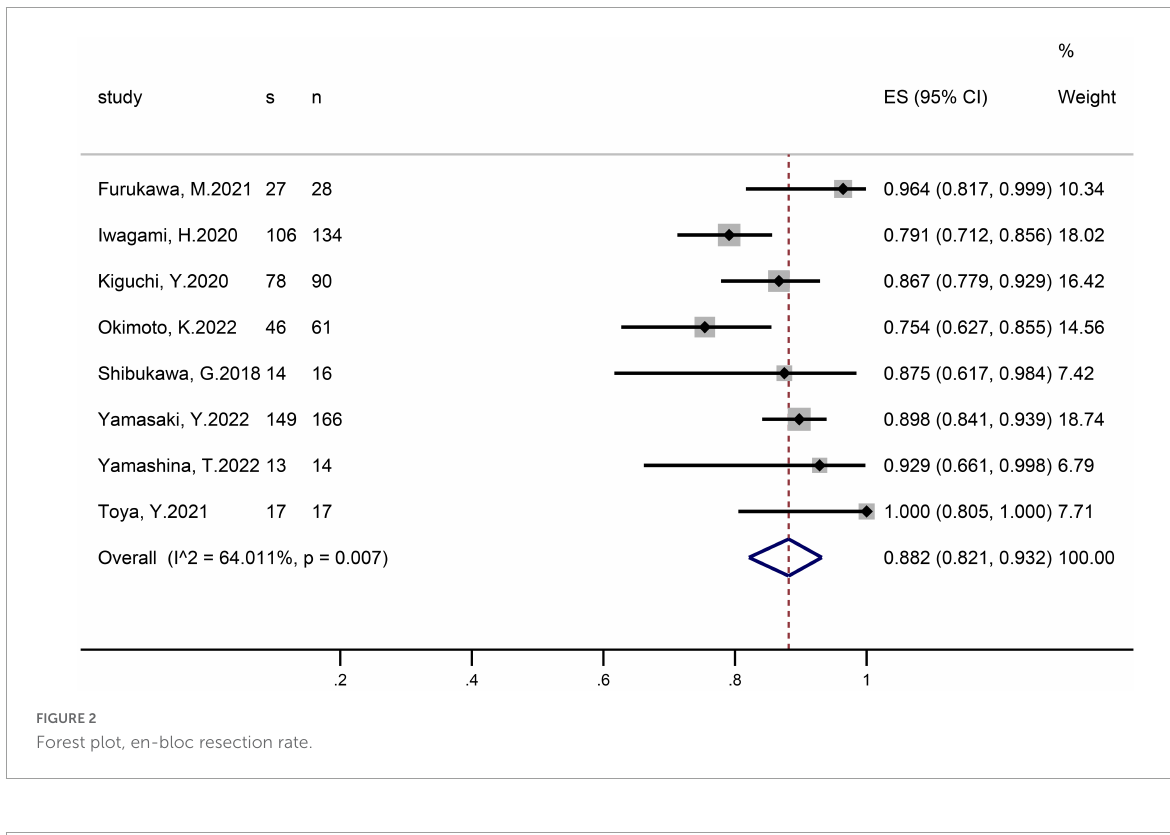
FIGURE2 Forest plot, en-bloc resection rate.